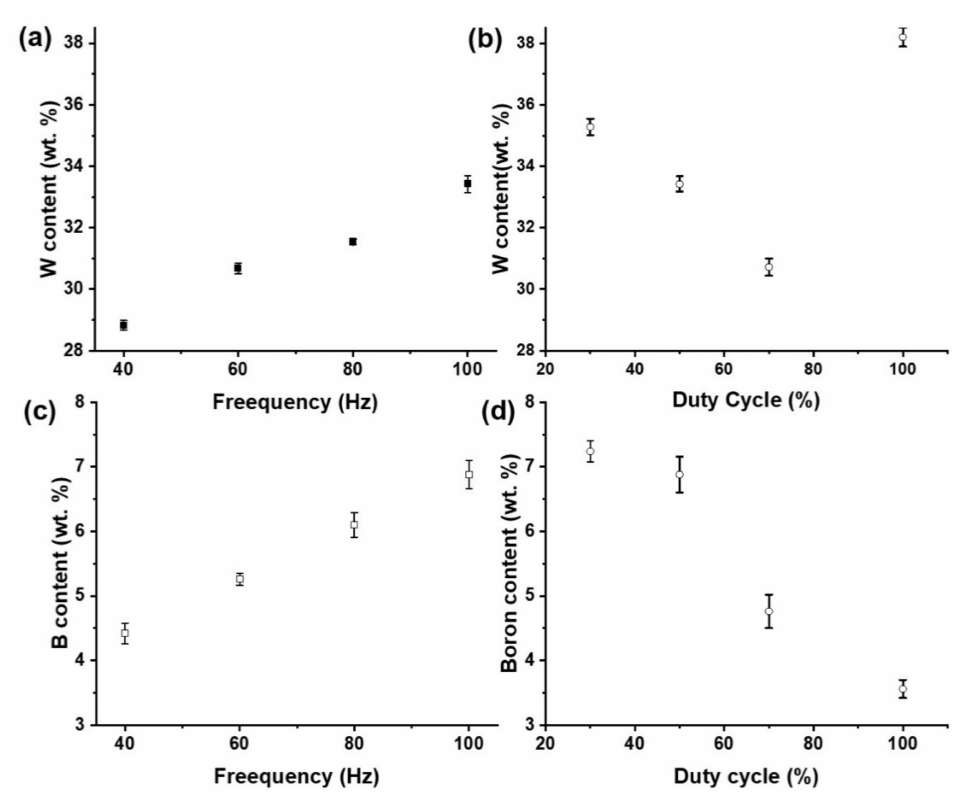
Figure 4. Tungsten content in the coatings, ( a ) varying by frequency at 50% duty cycle, ( b ) varying by duty cycle at frequency of 100 Hz. Boron content in the coatings, ( c ) varying by frequency at 50% duty cycle, ( d ) varying by duty cycle at frequency of 100